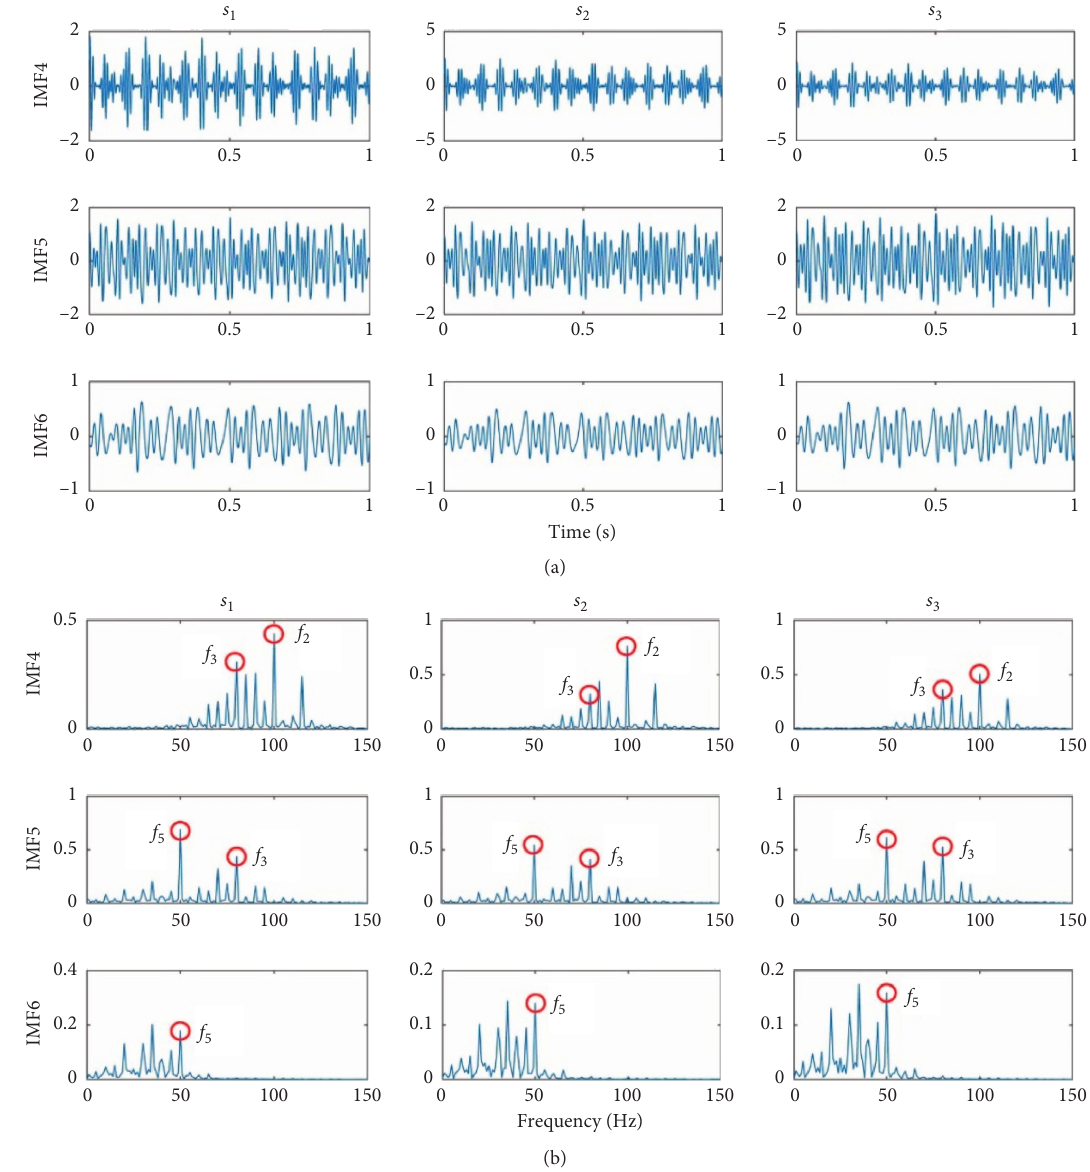
Figure 2: The decomposition results by MEMD (IMF4–IMF6). (a) Time domain. (b) Frequency